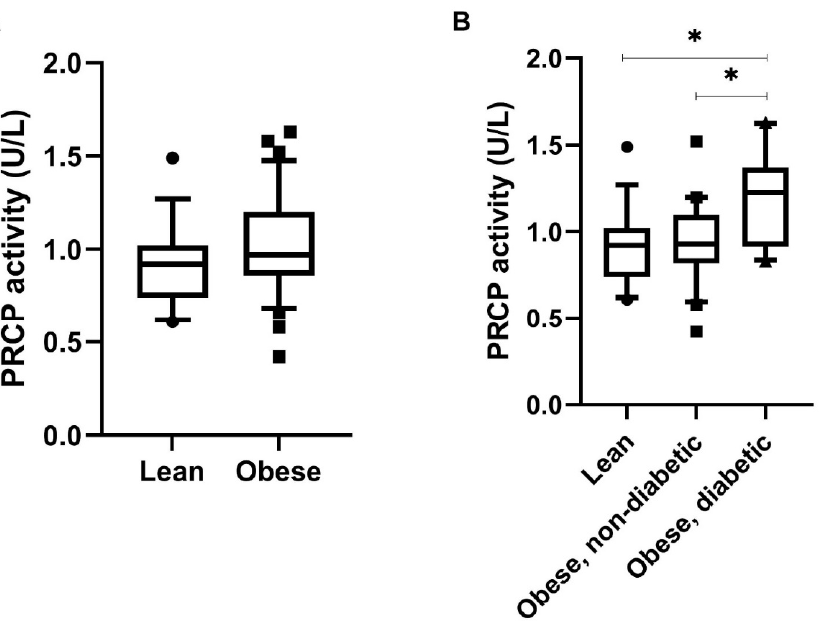
Figure 4. Serum PRCP activity (U/L) in lean and obese men with or without T2D. ( A ) PRCP activity measured in serum of lean men ( n = 19) and obese men ( n = 31). ( B ) PRCP activity measured in serum of lean men ( n = 19), obese men without T2D ( n = 21) and obese men with T2D ( n = 10) (* p < 0.05). Results are presented as boxplots with 10–90 percentile. Significant differences are indicated on the graphs (* p < 0.05). Circles: PRCP activity values for lean individuals; Squares: PRCP activity values for Obese individuals ( A ) or for Obese, non-diabetic individuals ( B ); Triangles: PRCP activity values for Obese, diabetic individuals; Boxes: Boxplots with 10-90 percentile.